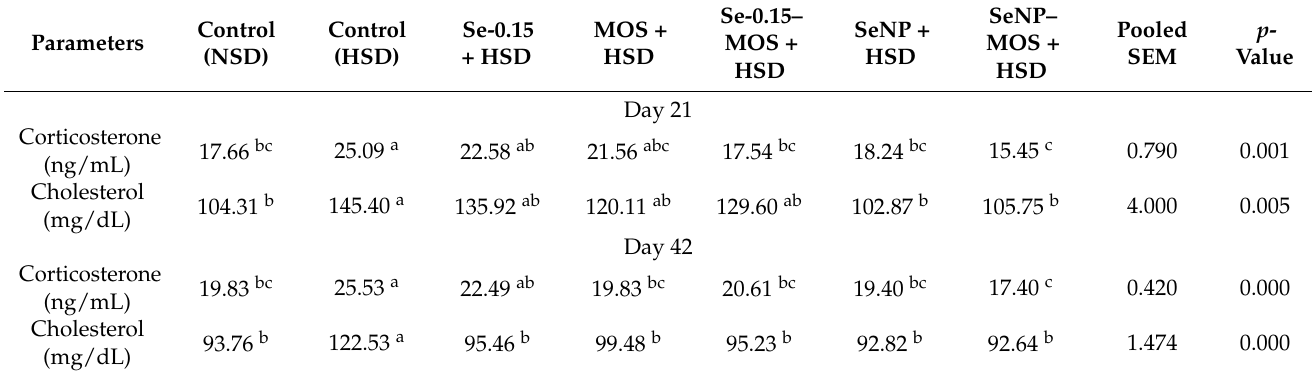
Table 7. Effect of selenium nanoparticles–MOS on serum stress indicators in broilers chickens reared under higher stocking